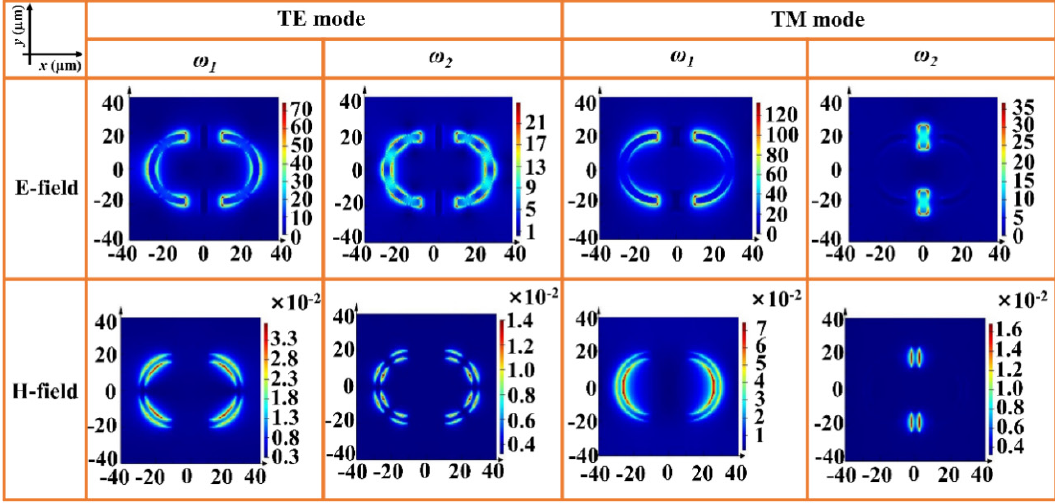
Figure 6. E- and H-field distributions of eSRR with L = 12 μ m in TE and TM modes.